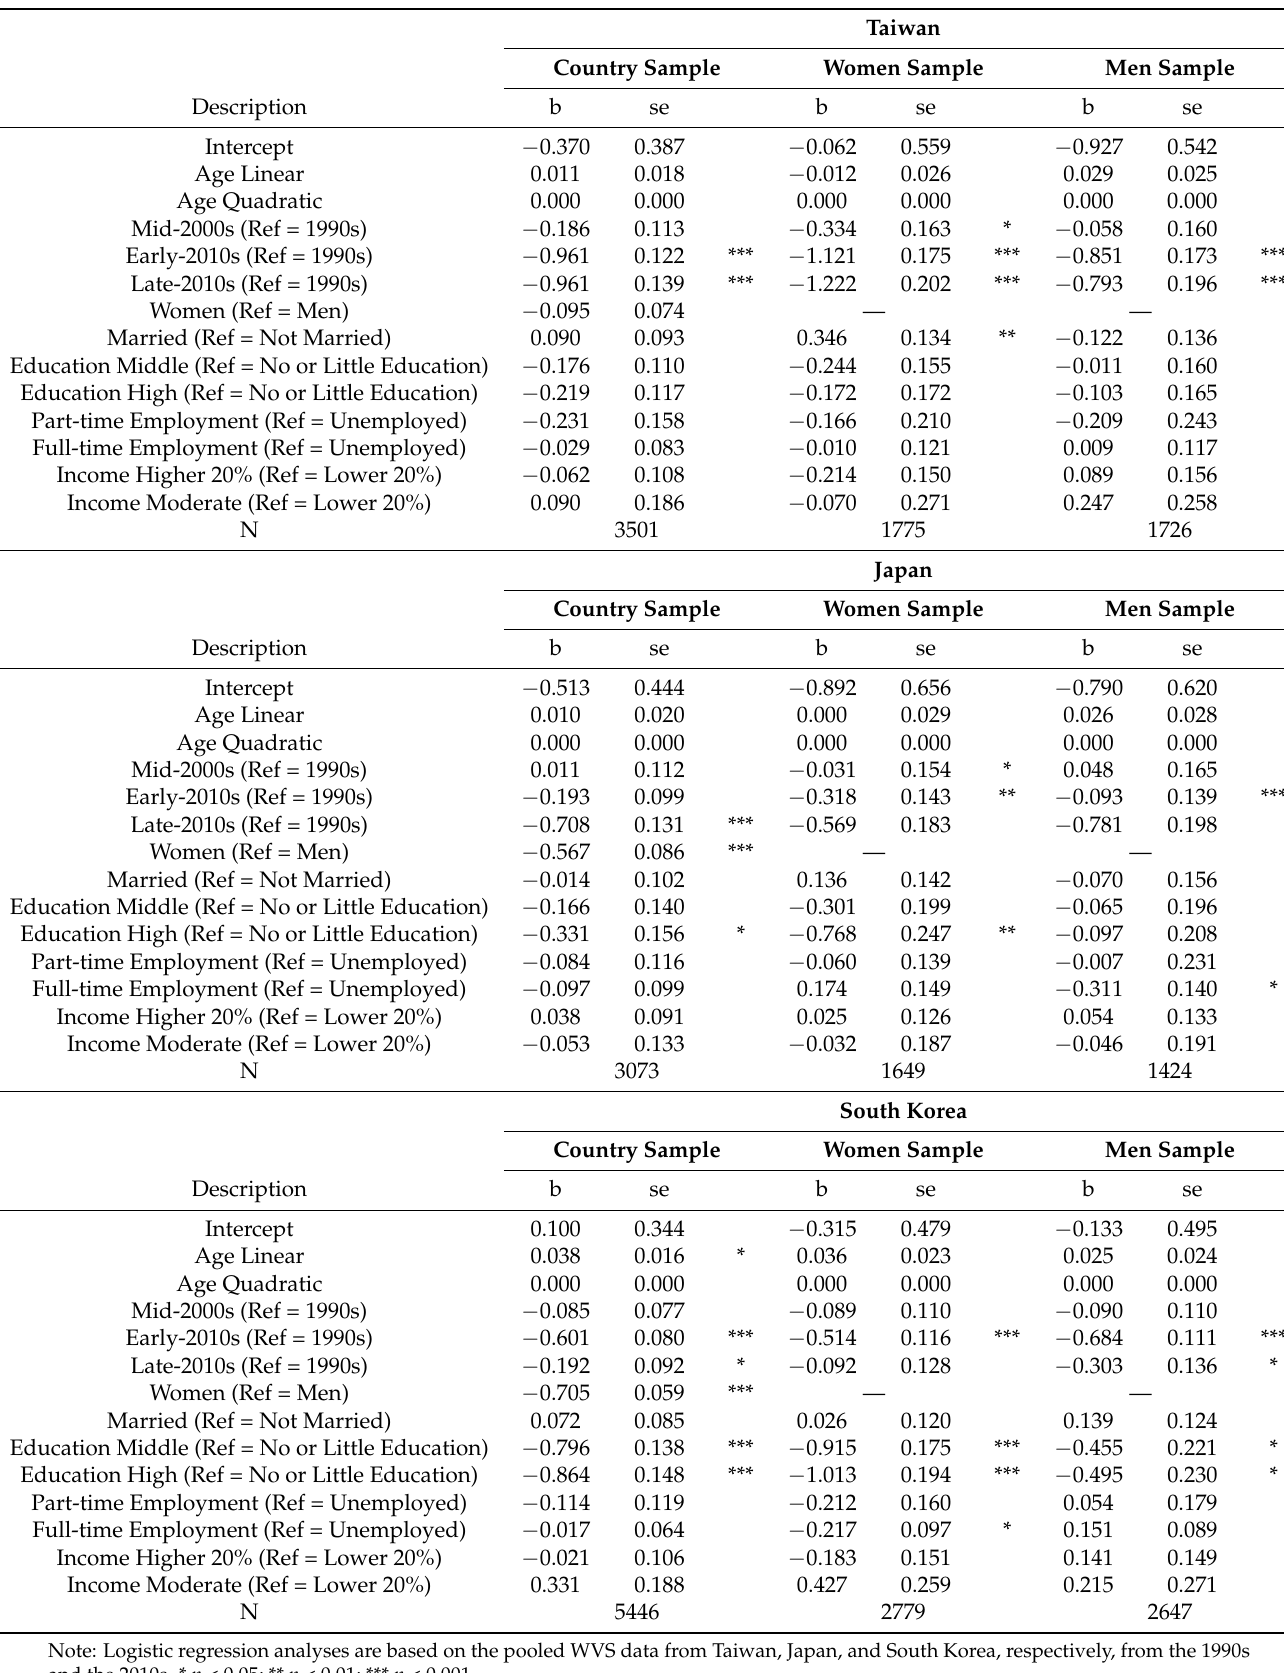
Table 5. Country subsample logistic model results for attitude about women political leaders, the WVS